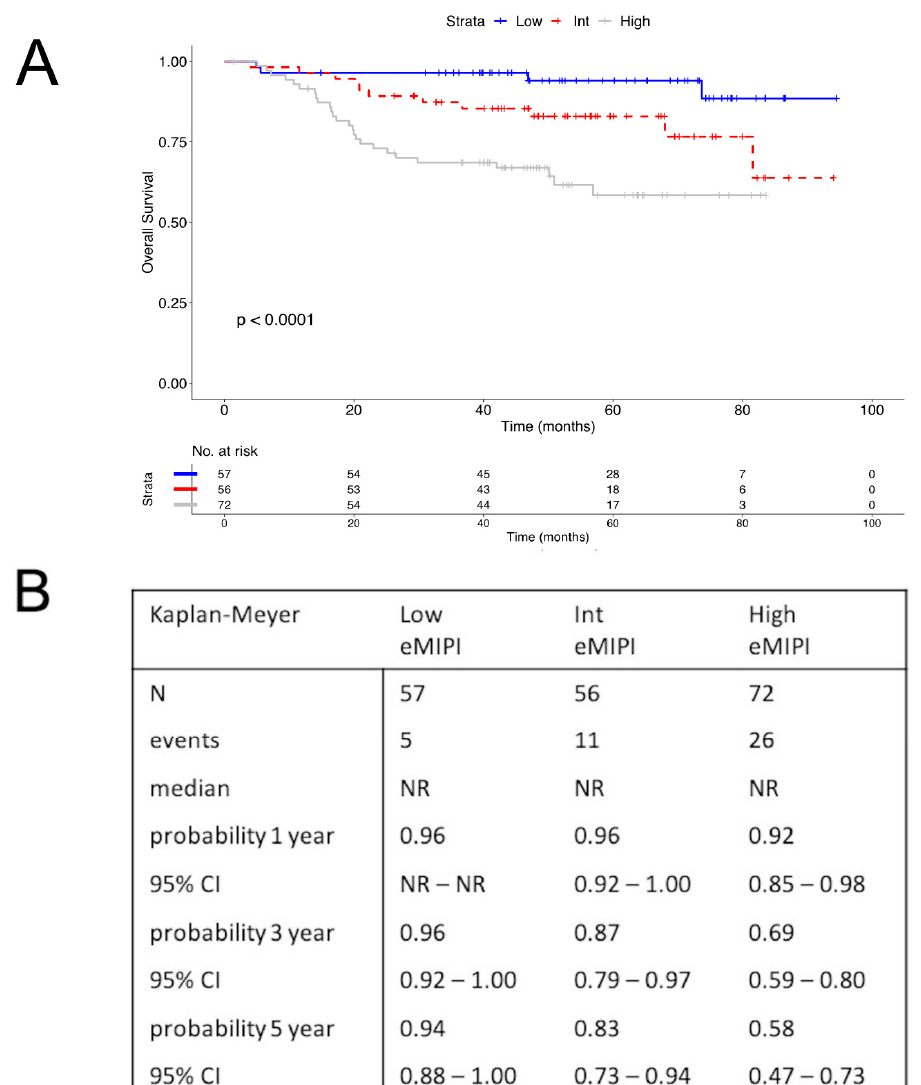
Figure 3 . Survival among patients with MCL, according to eMIPI values. ( A ) Kaplan-Meier curve shows OS and numbers at risk for patients with Low, Int, and High eMIPI values. ( B ) OS estimated at 1, 3, and 5 years, in patients with Low, Int, and High eMIPI values. Abbreviations: MCL: mantle cell lymphoma; MIPI: international MCL prognostic index; eMIPI: engineered MIPI; OS: overall survival; N: number; Int: intermediate; NR: not reached; CI: confidence interval.